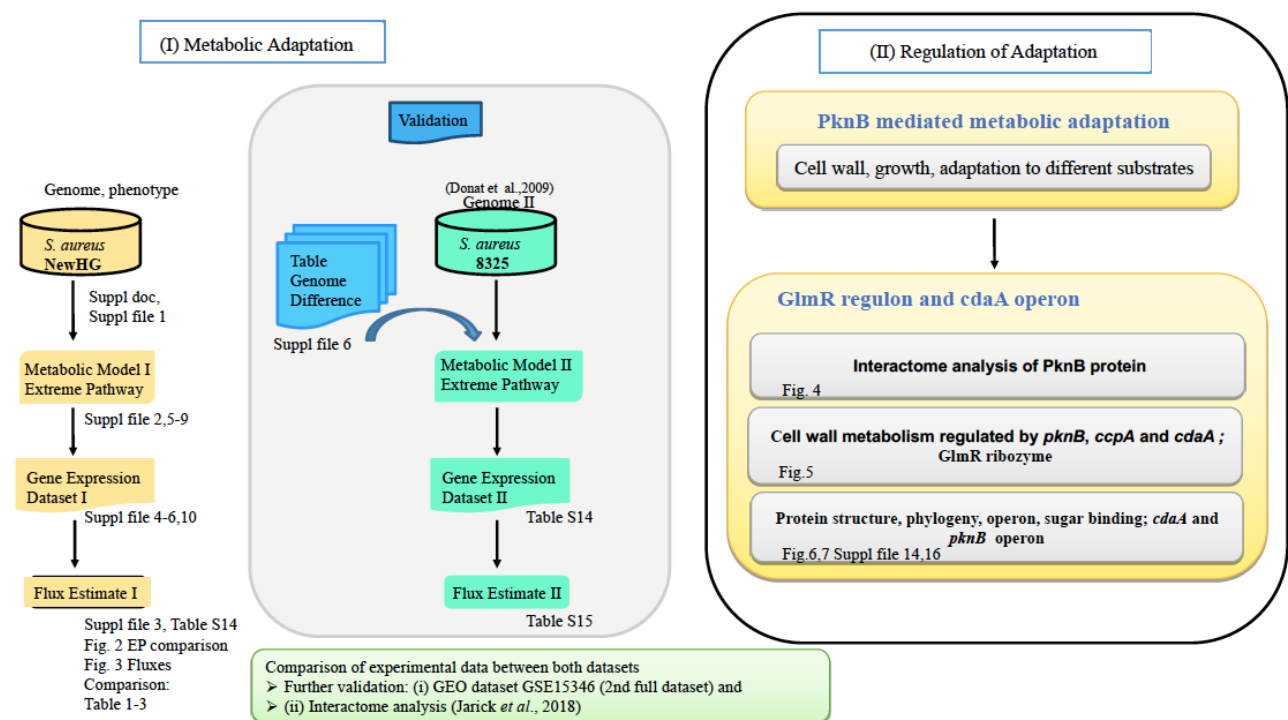
Figure 1. Study workflow of S. aureus metabolism. Left: metabolic pathway fluxes were calculated using a first gene expression dataset of S. aureus strain NewHG comparing the wild type to pknB , stp and double-knockout mutants. Validation data (blue boxes) included individual qRT-PCR of selected virulence and metabolic genes and a second gene expression dataset of S. aureus strain NCTC 8325 (global comparison). Right: the glmR / yvcK regulon and the cdaA regulon are important for this. Interactions between these regulatory proteins and PknB involve (i) interactome analysis and validation with published datasets and (ii) operon/regulon model as well as phylogenetic analysis (highly conserved phosphorylation sites and data from other Gram-positive bacteria, including alignment, homology model and phylogenetic tree and model of the riboswitch).